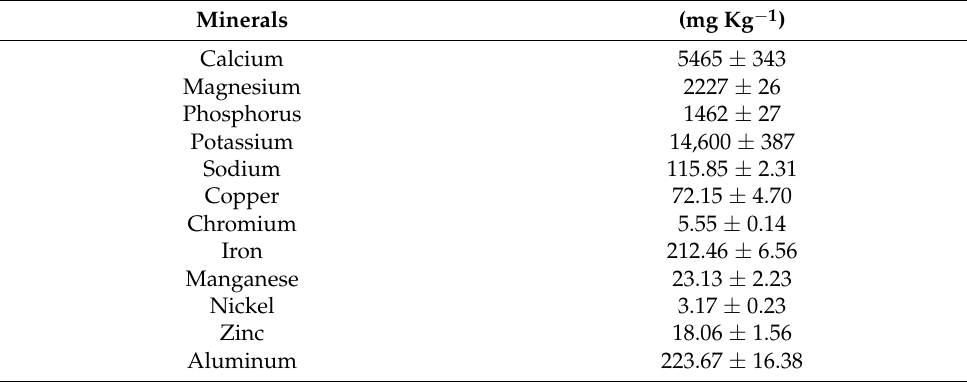
Table 4. Mineral composition (mg Kg − 1 ) of